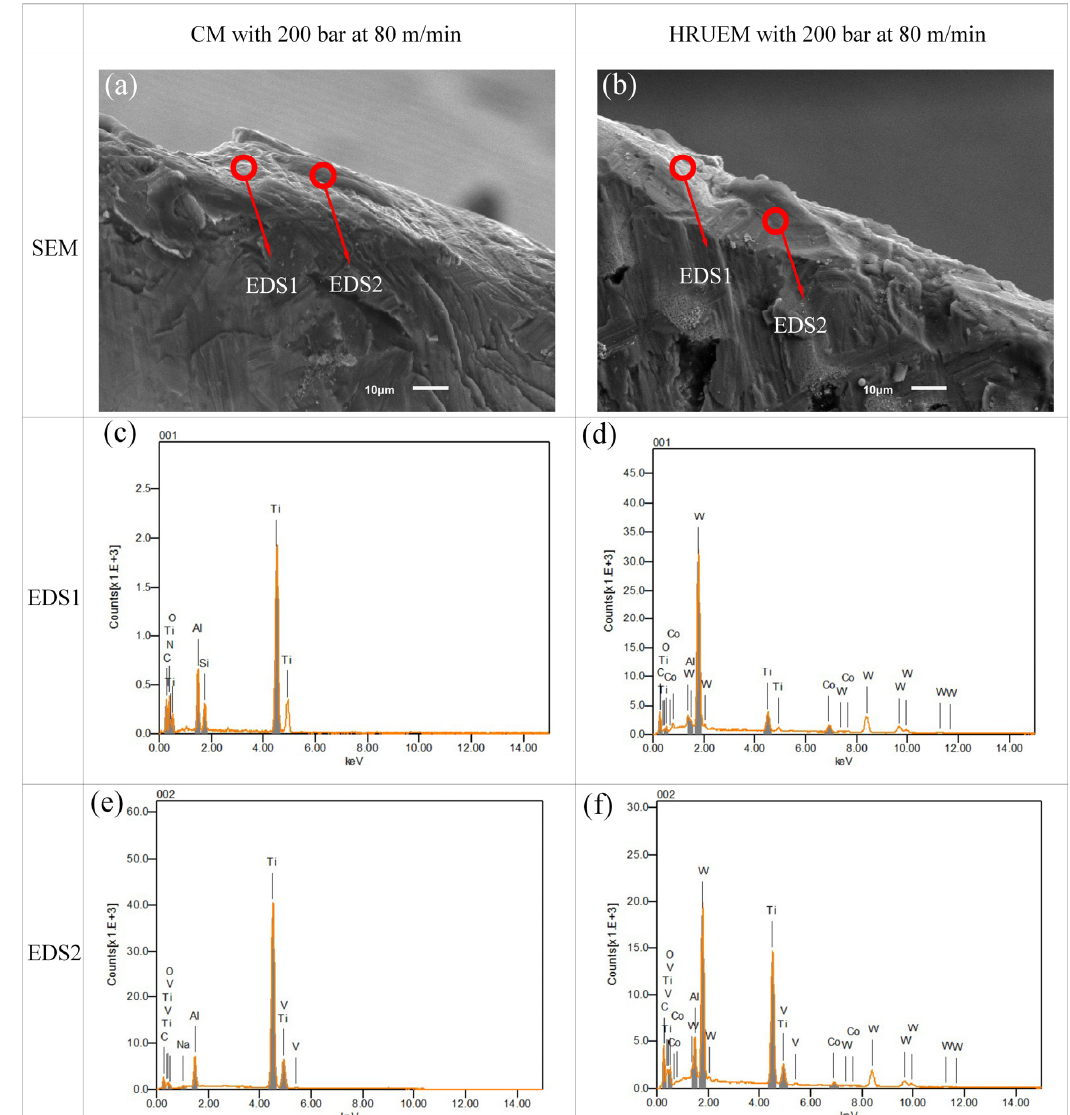
Figure 12. SEM micrographs and EDS analyses of CM and HRUEM with 200 bar: ( a ) SEM micrographs of CM, ( b ) SEM micrographs of HRUEM, ( c ) EDS1 analyses of CM, ( d ) EDS1 analyses of